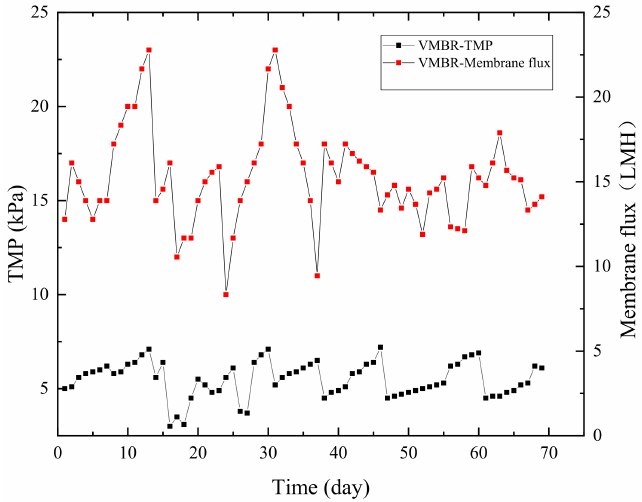
Figure 12. The TMP and membrane flux of A 2 /O-VMBR and AMBR during daily operation.